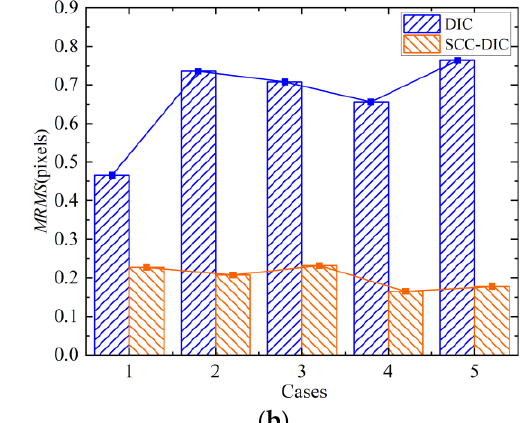
Figure 11. ( a ) MMAE of the two methods; ( b ) MRMS of the two methods.